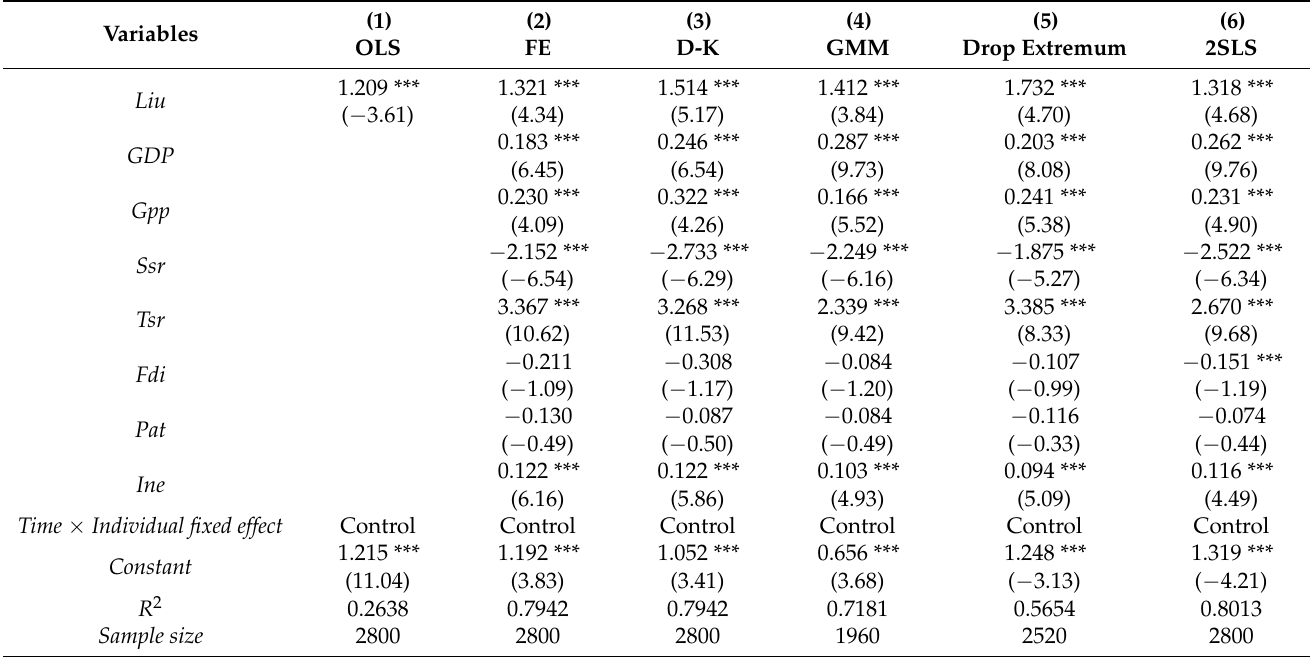
Table 2. Benchmark regression